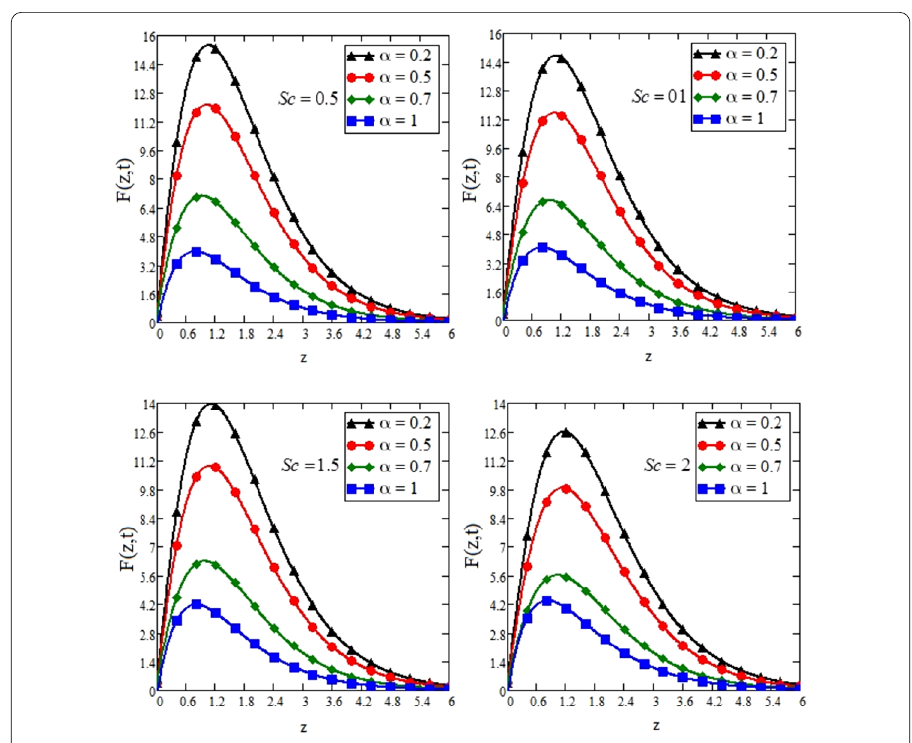
Figure 9 Impact of Sc on the velocity distribution of Jeffrey nanofluid